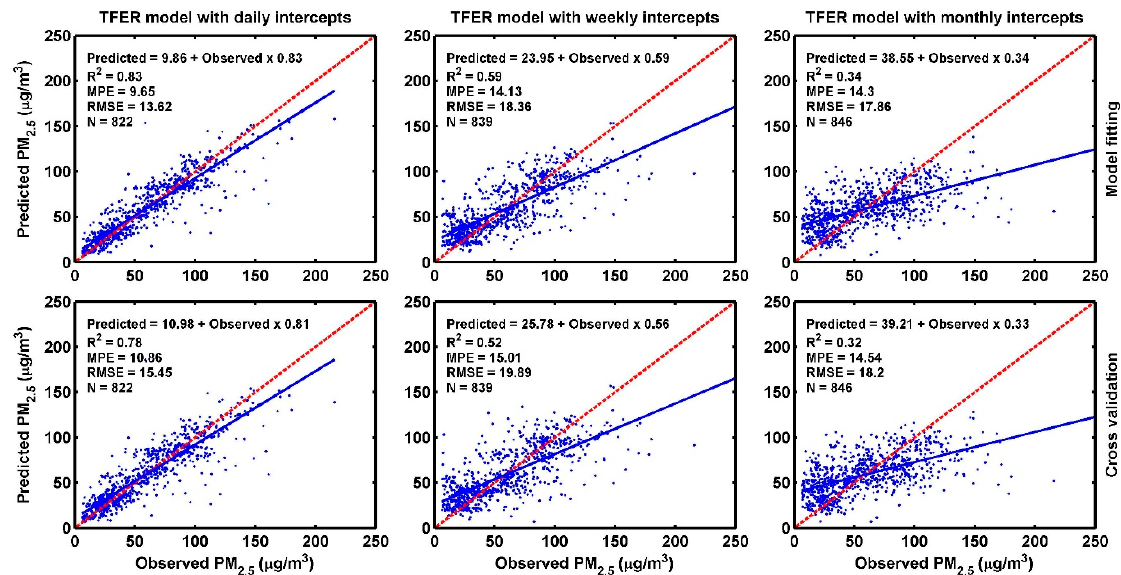
Figure 6. Model fitting and sample-based ten-fold CV results for the nested AOD-only TFER model. Table 2. F tests between the full and non-AOD models for the first-stage nested TFER model.